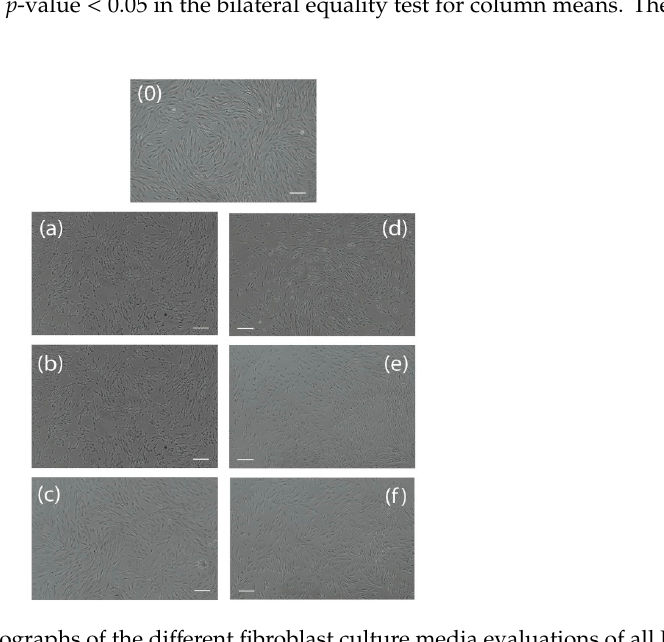
Figure 3. Stereotypical micrographs of the different fibroblast culture media evaluations of all LBMs: 0 control group, ( a ) FC30, ( b ) FC50, ( c ) FC70, ( d ) FL30, ( e ) FL50, and ( f ) FL70. Bar 100 µm. Table 4. Morphological conditions of cell